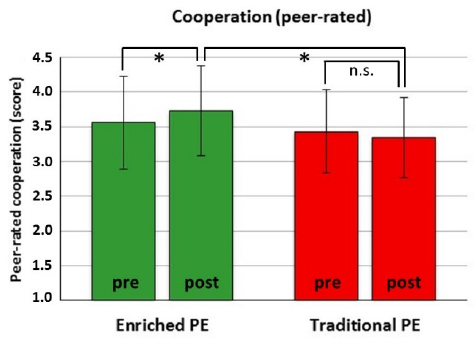
Figure 5. Peer-rated cooperation scored with the Multisource Assessment of Social Competence Scale before (pre) and after (post) the actual enriched PE intervention or the traditional PE. * p < 0.016 (adjusted for three comparisons); n.s.: non-significant.